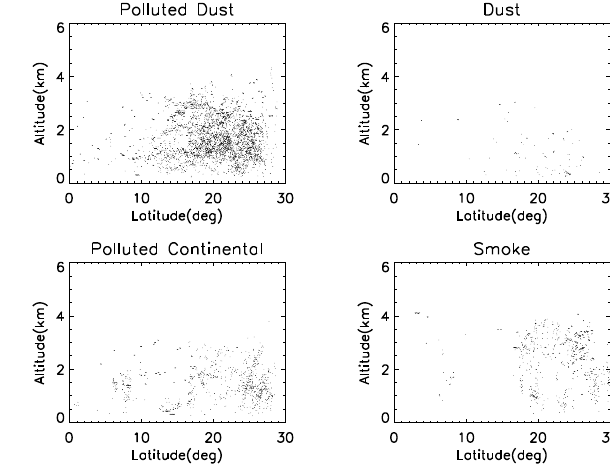
Fig. 7. Altitude of aerosol layer tops (above the surface) from CALIPSO over Eastern IGP for various seasons in 2007. The DJF plot includes data from December 2006-February 2007. Only night time data with CAD scores of − 100 were used.